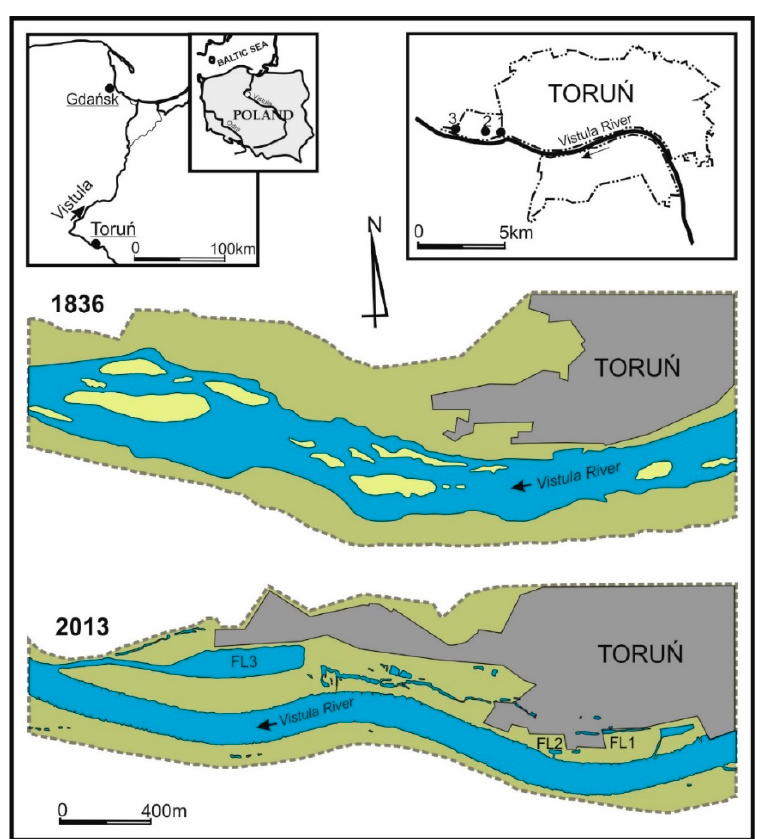
Figure 1. Hydrological system of the lower Vistula River in Toru ń (Poland) before regulation (1836) and today (2013). FL1—floodplain lake isolated from the river, FL2—floodplain lake periodically connected to the river (transitional), FL3—floodplain lake permanently connected to the